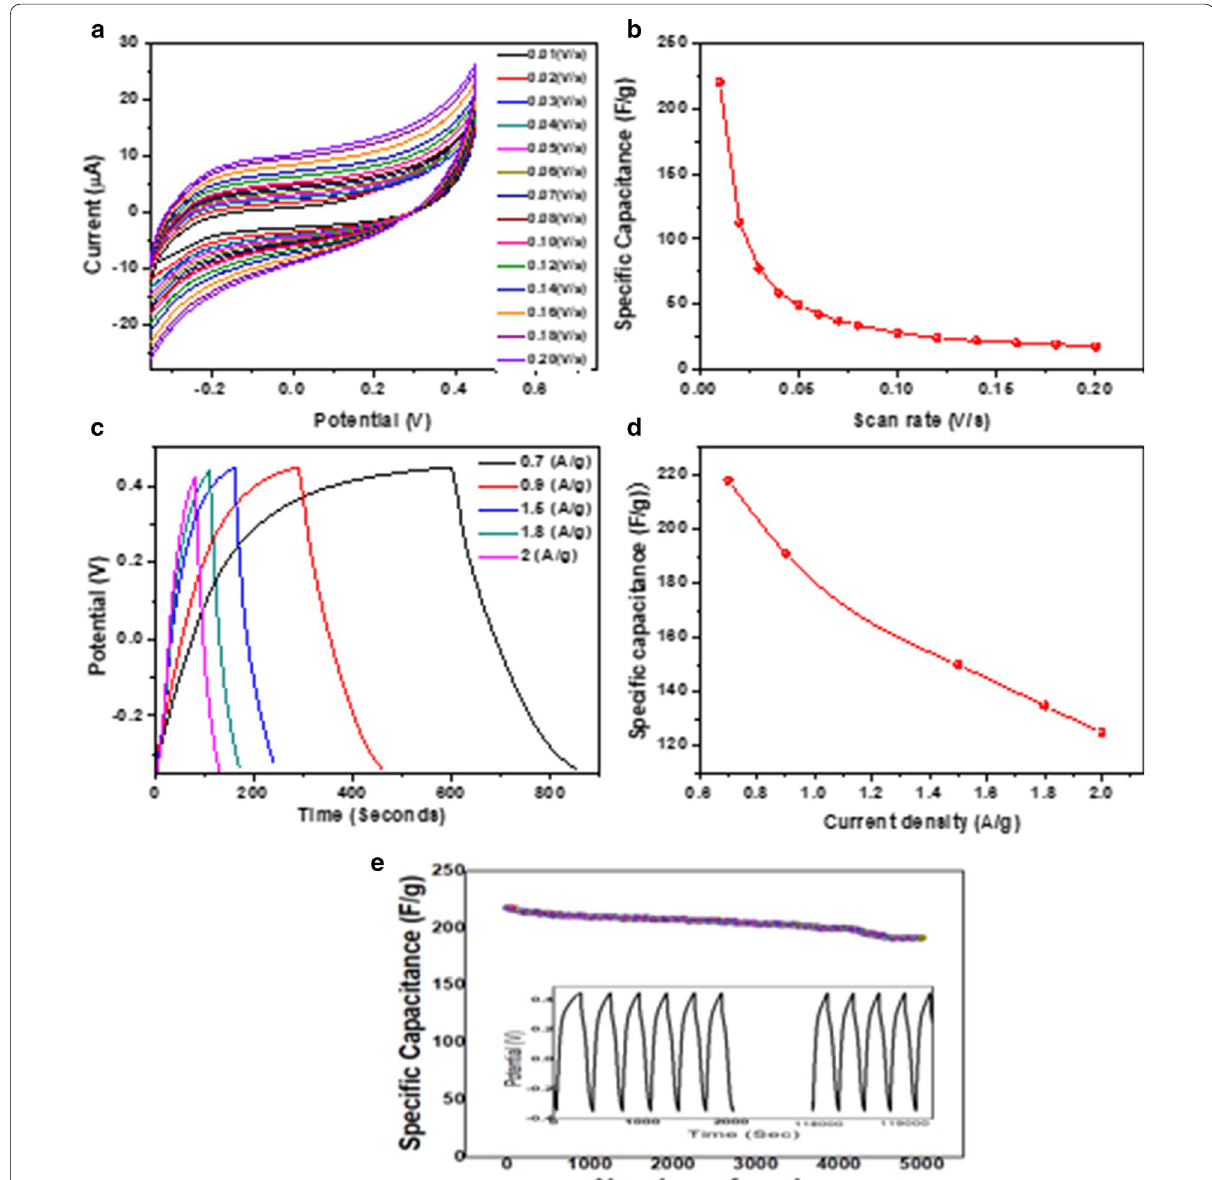
Fig. 7 a Cyclic voltammogram (CV) at different scan rates, b specific capacitance through CV, c galvanostatic charge–discharge curves at different current densities, d specific capacitance through GCD, e cyclic stability of the as-synthesized DP-AC electrode material up to 5000th cycle with initial and final cycles at a current density of 0.7 A g −